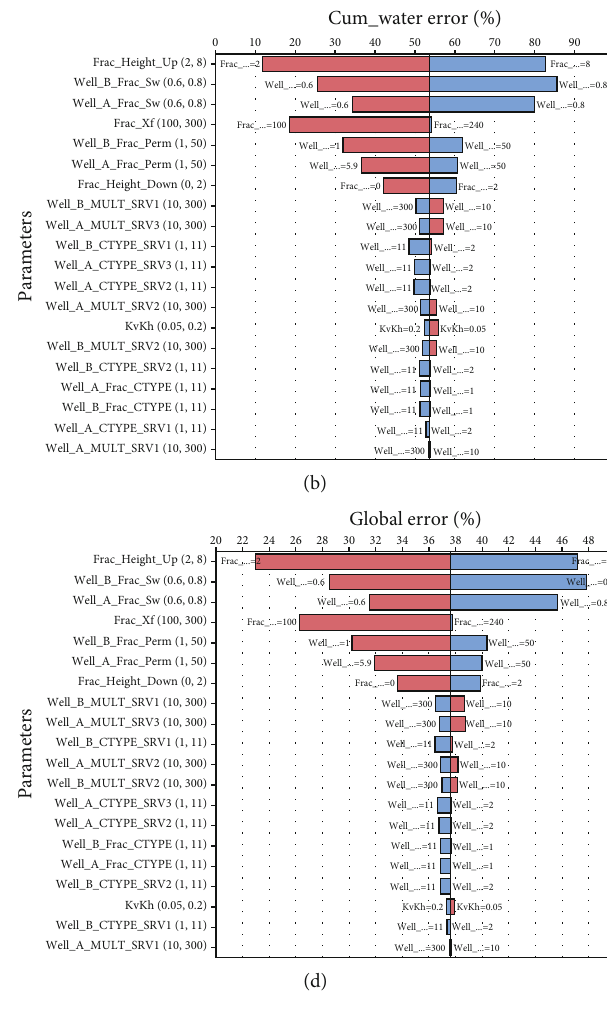
Figure 7: Tornado charts for sensitivity analysis results: (a) cumulative gas production error, (b) cumulative water production error, (c) bottom-hole pressure error, and (d) the global error which is the weighted sum of the three